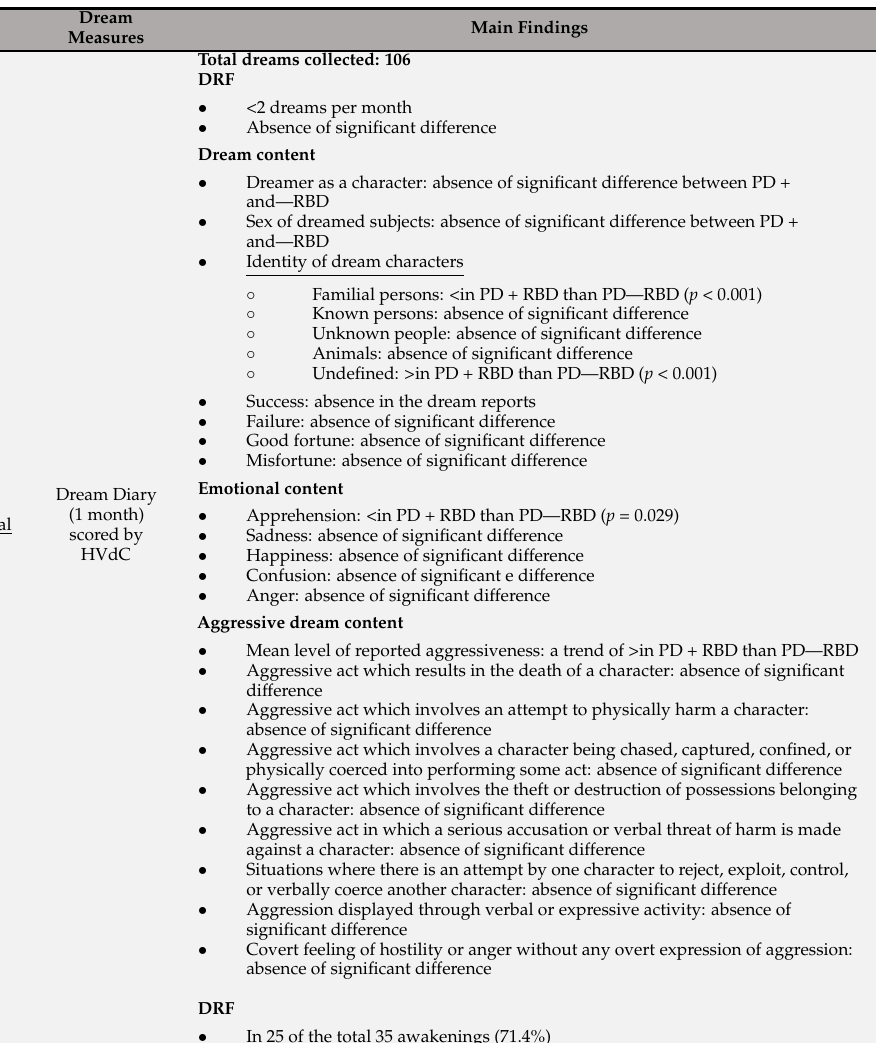
Table 2. Sample, design, tools, and findings in studies investigating dreaming in RBD with and without neurodegenerative